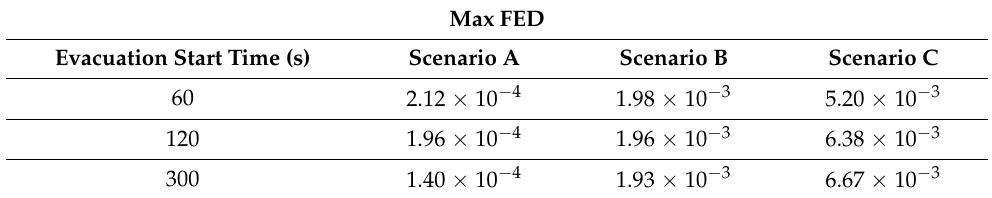
Table 1. Max FED index for the three different scenarios and evacuation times.